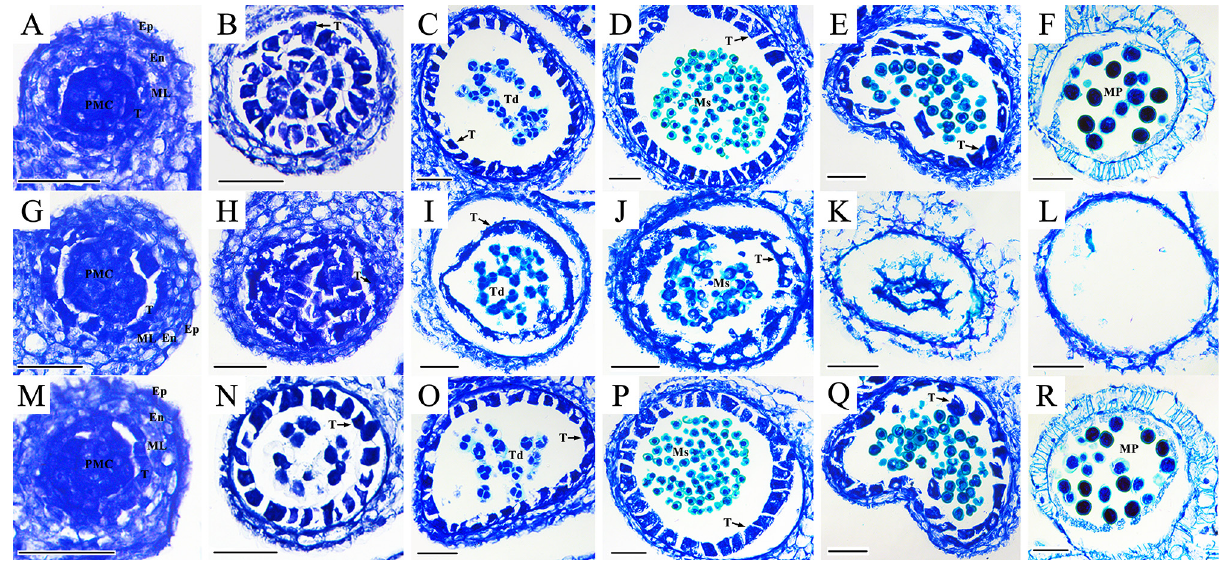
Figure 2. Cytological observation of anthers in the maintainer line, Ogura CMS line, and restorer line. ( A – F ) Maintainer line 19–616. ( G – L ) Ogura CMS 19–2167. ( M – R ) Restorer line FR2202. ( A , G , M ) Microsporocyte stage. ( B , H , N ) Meiotic stage. ( C , I , O ) Tetrad stage. ( D , J , P ) Uninucleate stage. ( E , K , Q ) Bicellular microspore stage to trinucleate microspore stage. ( F , L , R ) Mature pollen stage. Bar = 50 µ m. PMC, pollen mother cell; Ep, epidermis; En, endothecium; ML, middle layer; T, tapetum;